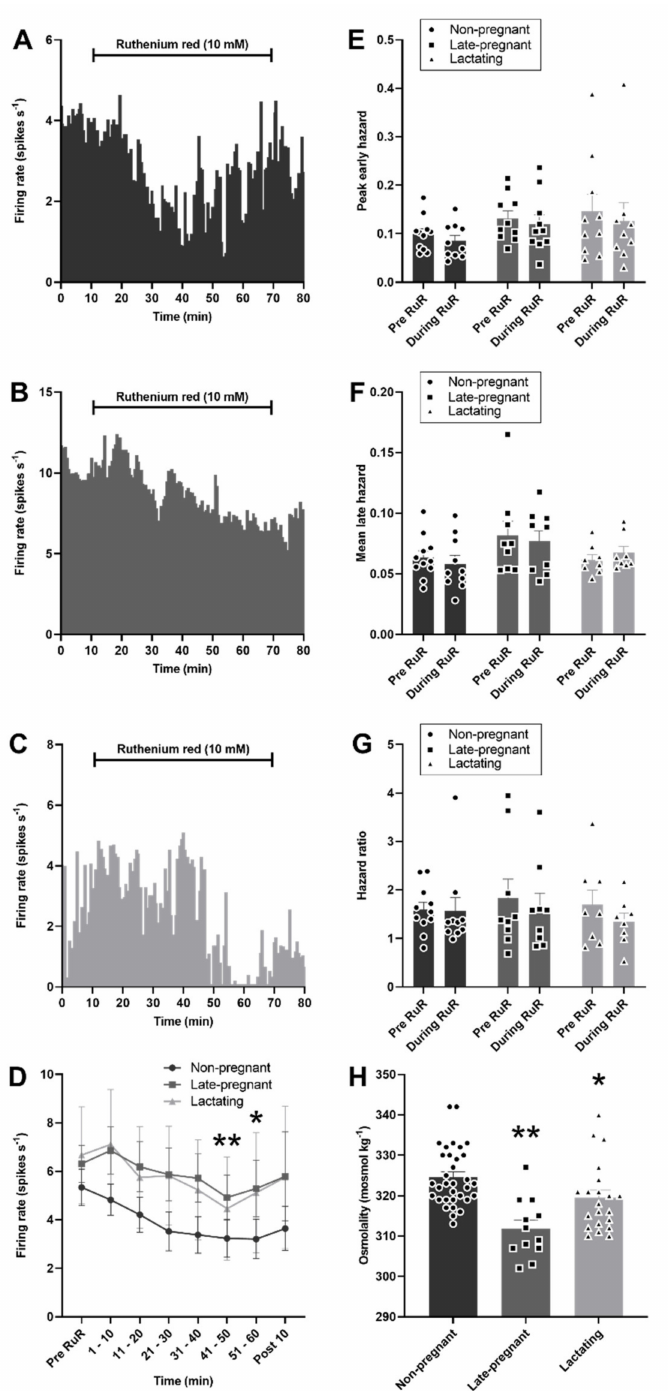
Figure 6. Ruthenium red inhibited vasopressin neuron activity in non-pregnant, late-pregnant, and lactating rats. ( A – C ) Ratemeter recordings (in 30 s bins) of the firing rates of vasopressin neurons in non-pregnant ( A ), late-pregnant ( B ), and lactating ( C ) rats before and during microdialysis adminis- tration of ruthenium red (RuR; 10 mM). ( D ) Mean firing rate (in 10 min bins ± SEM) of vasopressin neurons in non-pregnant, late-pregnant, and lactating rats before and during microdialysis adminis- tration of ruthenium red (10 mM). Ruthenium red induced a similar reduction in the firing rate of vasopressin neurons in non-pregnant, late-pregnant, and lactating rats (REPRODUCTIVE STATUS: F 2,28 = 0.69, p = 0.51; TIME: F 6,28 = 5.94, p < 0.001; interaction between REPRODUCTIVE STATUS and TIME: F 12,32 = 0.29, p = 0.99, two-way repeated measures ANOVA). * p < 0.05 and ** p < 0.01 compared to pre-RuR within TIME, Holm–Sidak post hoc tests. ( E – G ) Mean ( ± SEM) peak